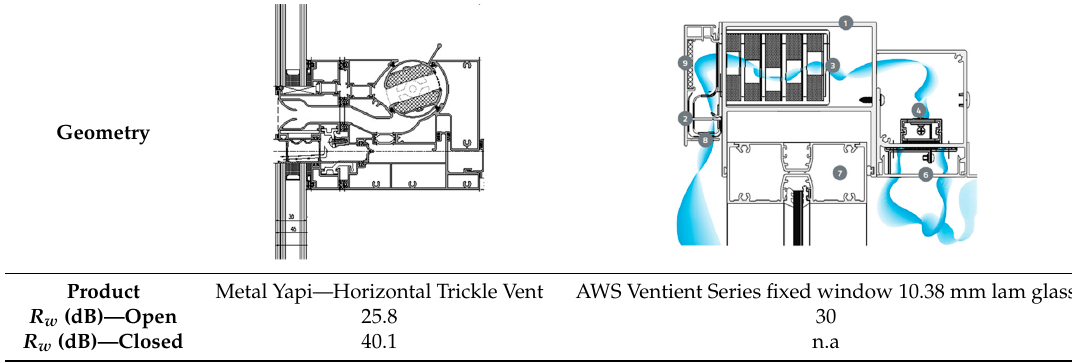
Table 10. R w values of various Trickle Vent products [14,99].